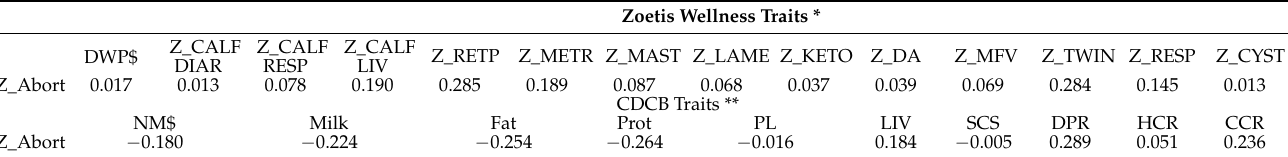
Table 4. Correlation of Z_Abort STA with Zoetis genetic evaluation for wellness traits STAs in Holsteins (n = 1,542,856) and CDCB traits